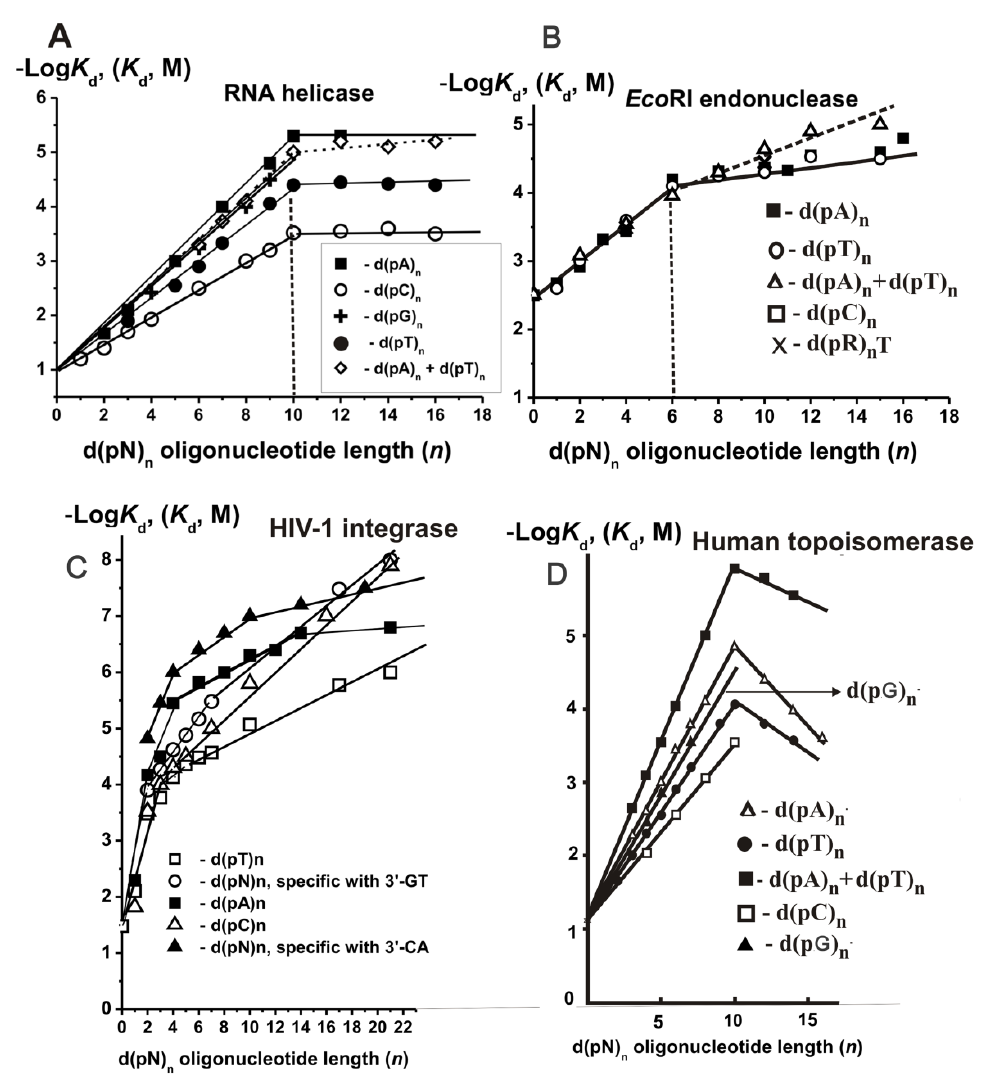
Figure 12. Dependencies of –Log K d for ss and ds d(pN) n deoxyribooligonucleotides versus their length ( n ) in the case of RNA–DNA helicase ( A ) [12,13], Eco R1 endonuclease ( B ) [92,93], HIV-1 integrase ( C ) [94,95], and human topoisomerase I ( D ) [96–98]. All types of enzymes and ODNs are shown on the panels; d(pR) n pT oligomers contain only one T base.